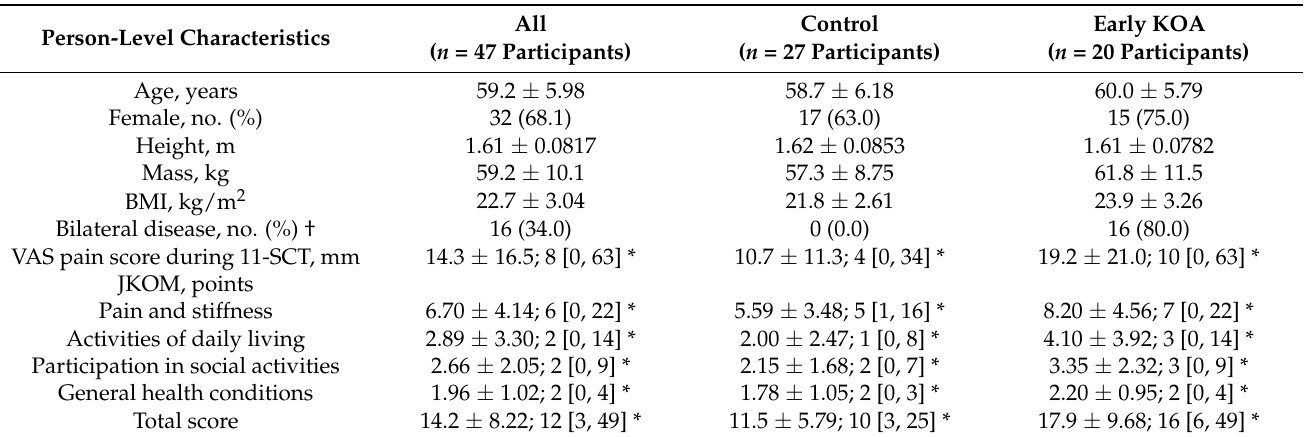
Figure 4. Comparison of RKJT values for K&L grades 0 and 1. ( A ) shows data for participants with K&L grade 0, and ( B ) shows data for K&L grade 1. The black lines show the analysis range, and the pink dots show the maximum and minimum points extracted. The four silhouettes correspond to the maximum and minimum values. Table 1. Characteristics of participants and their